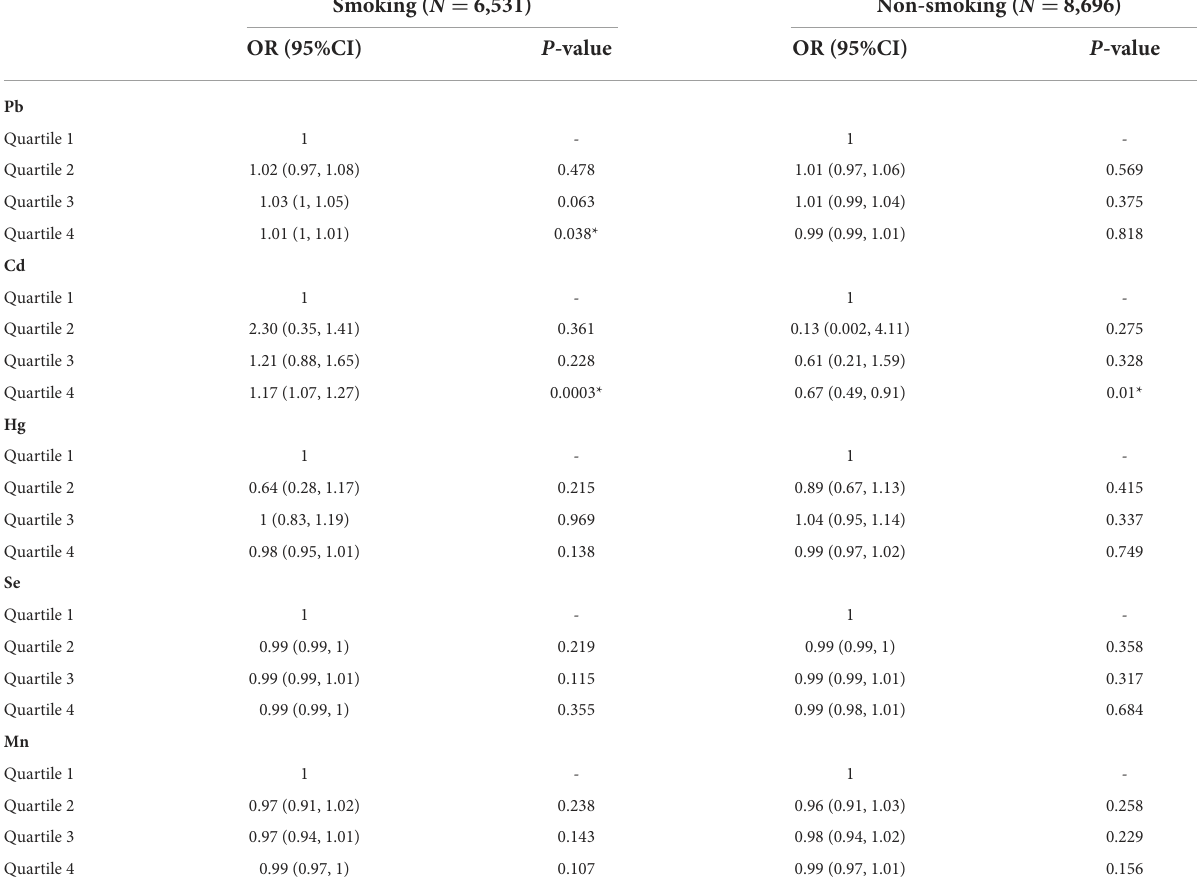
TABLE 4 Subgroup analysis of smoking in the association between blood metals (ug/L) and osteoarthritis in American aging people from NHANES 2011-2020. Smoking ( N =